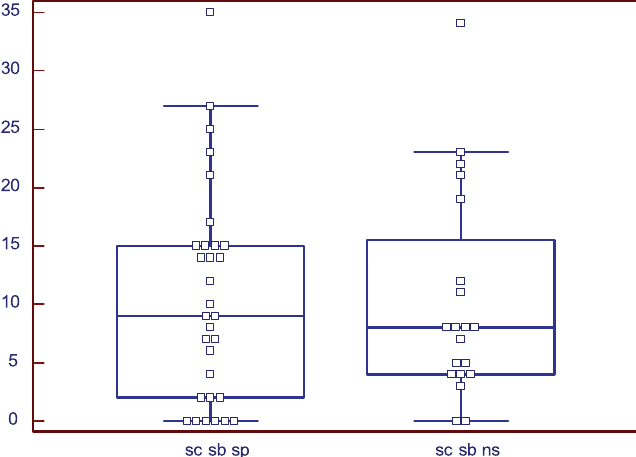
FIGURe 3. results obtained based on pain scale for both